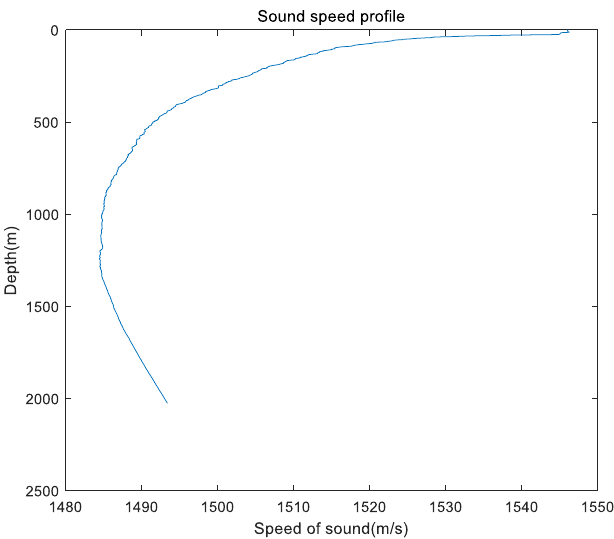
Figure 10. Sound speed profile.